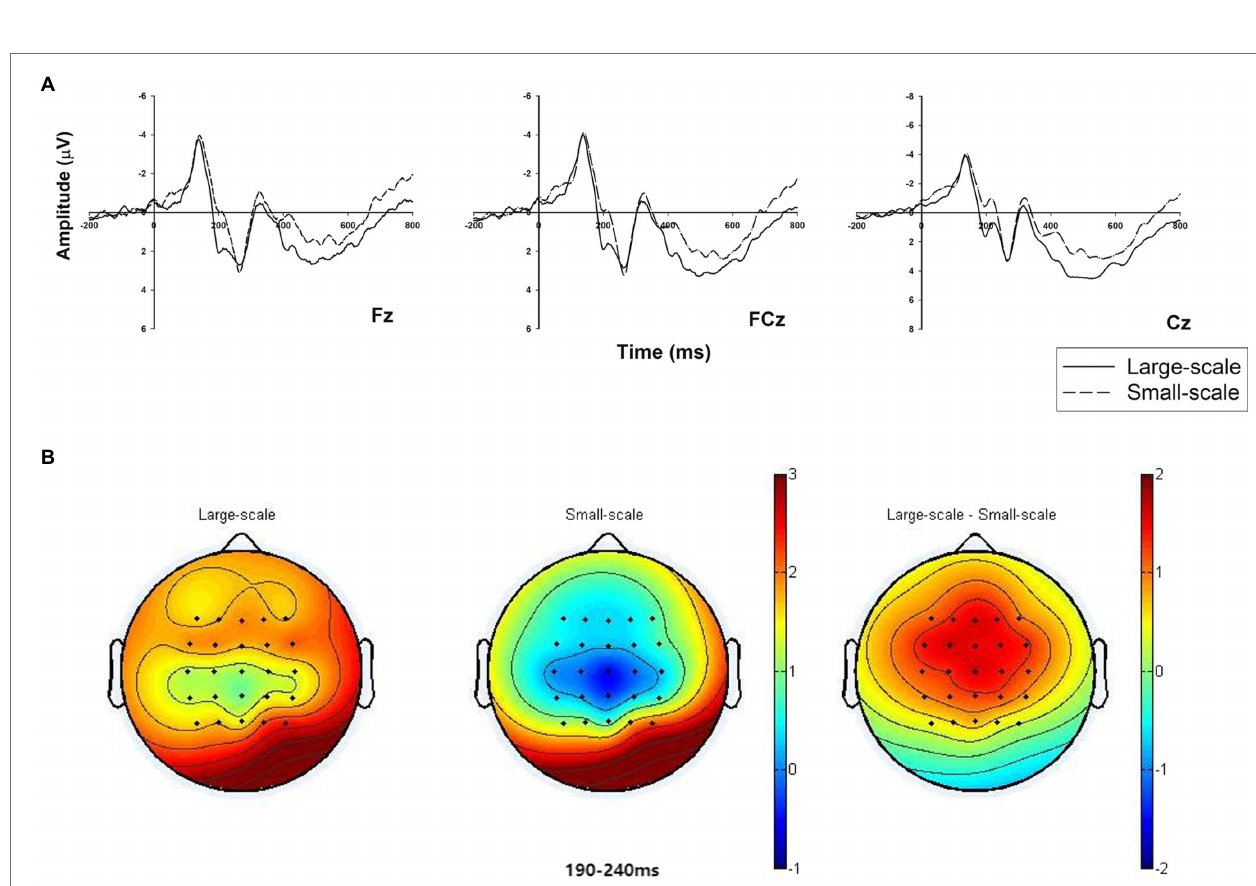
FIGURE 3 | Grand-averaged event-related potential (ERP) waveforms of N2 in the frontal-to-central region with three electrodes and related brain topography. (A) The N2 amplitude comparison under the two conditions of 3PL guaranteeing firms (large-scale vs. small-scale) at representative electrodes (Fz, FCz, and Cz). (B) Brain topography of the two conditions and a contrast at the N2 time window of 190–240